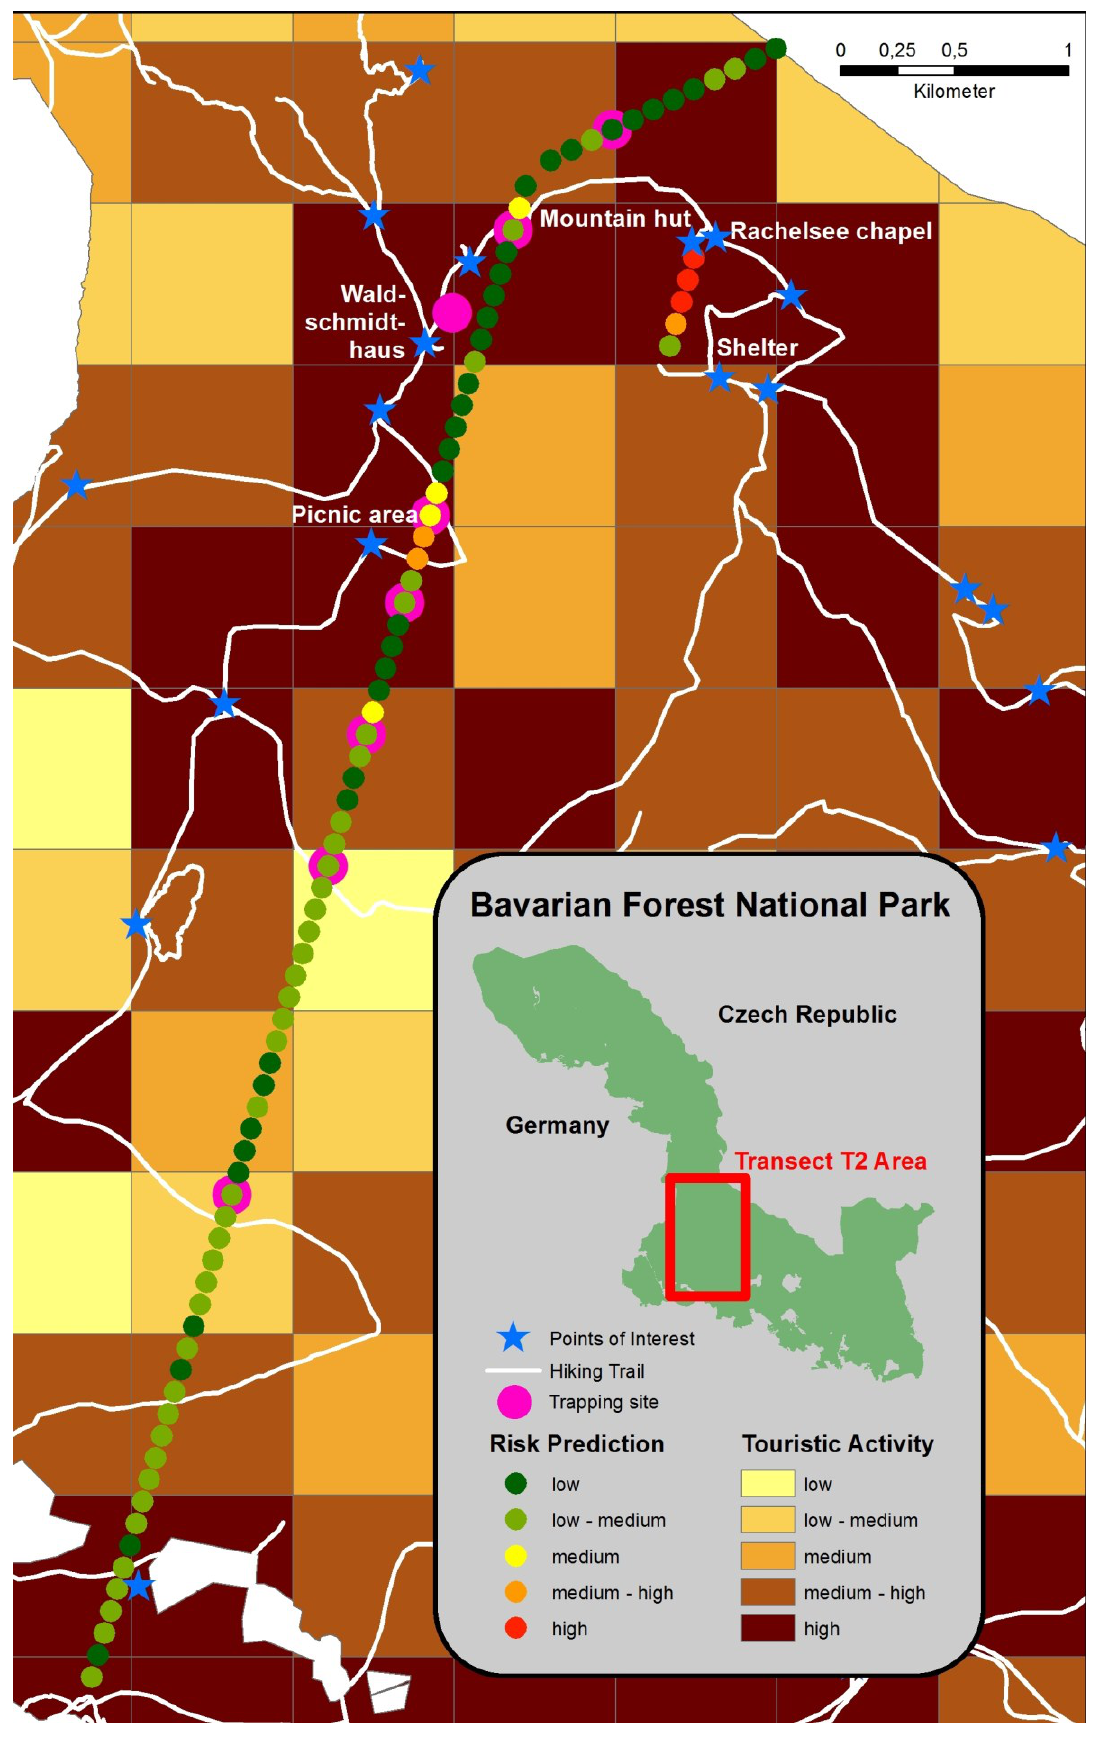
Figure 2. Illustrative risk prediction map for PUUV in bank voles in transect